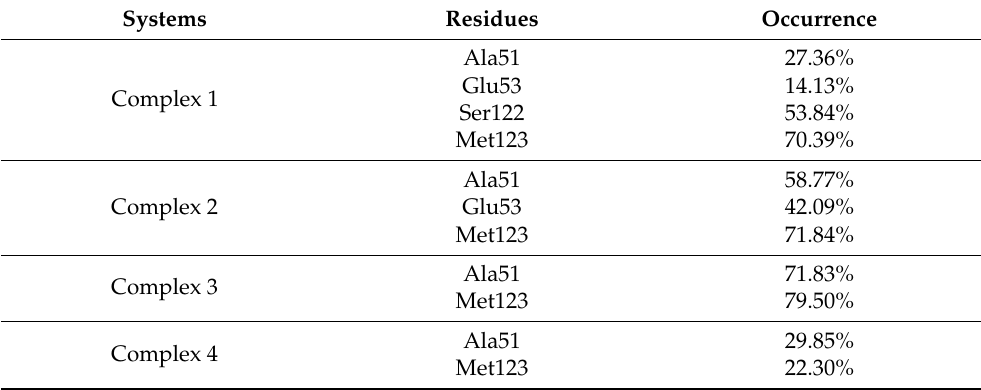
Table 2. The occurrence percentage of major hydrogen bonds in the four complexes during the